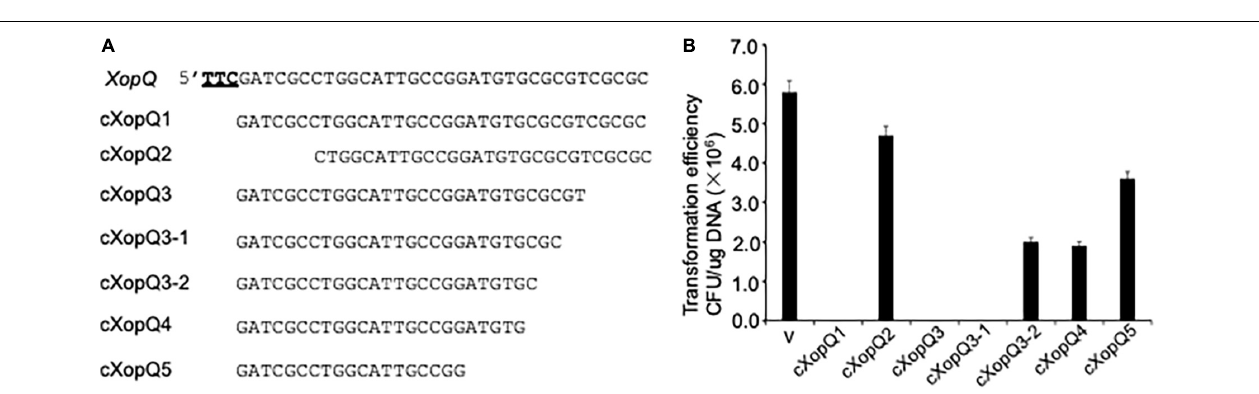
FIGURE 1 | Engineering constructs mimicking X. oryzae pv. oryzae CRISPR cassette. (A) The Xoo CRISPR locus is schematically shown. Cas genes are identified and indicated by arrows. Repeats are indicated by grey rectangles, spacers by white rhombuses. The leader sequence (LDR) is located between the cas2 gene and the CRISPR Cassette with the direction of transcription indicated. (B) Schematic diagram of the vector containing the CRISPR cassette mimicking that of Xoo . Sites of Btg Z I and Bsa I permit the insertion of two spacers for targeting sequences. (C) Plasmids containing spacers targeting spectinomycin resistance gene in the backbone of pHM1 or type III effector gene xopQ in Xoo were used for transformation assay of PXO99 A . Plasmid pHM1-XocRNA DR empty was used as a control. Transformation efficiency was calculated as colony-forming units (CFU) per microgram of plasmid DNA. Error bars represent 5% SDs.